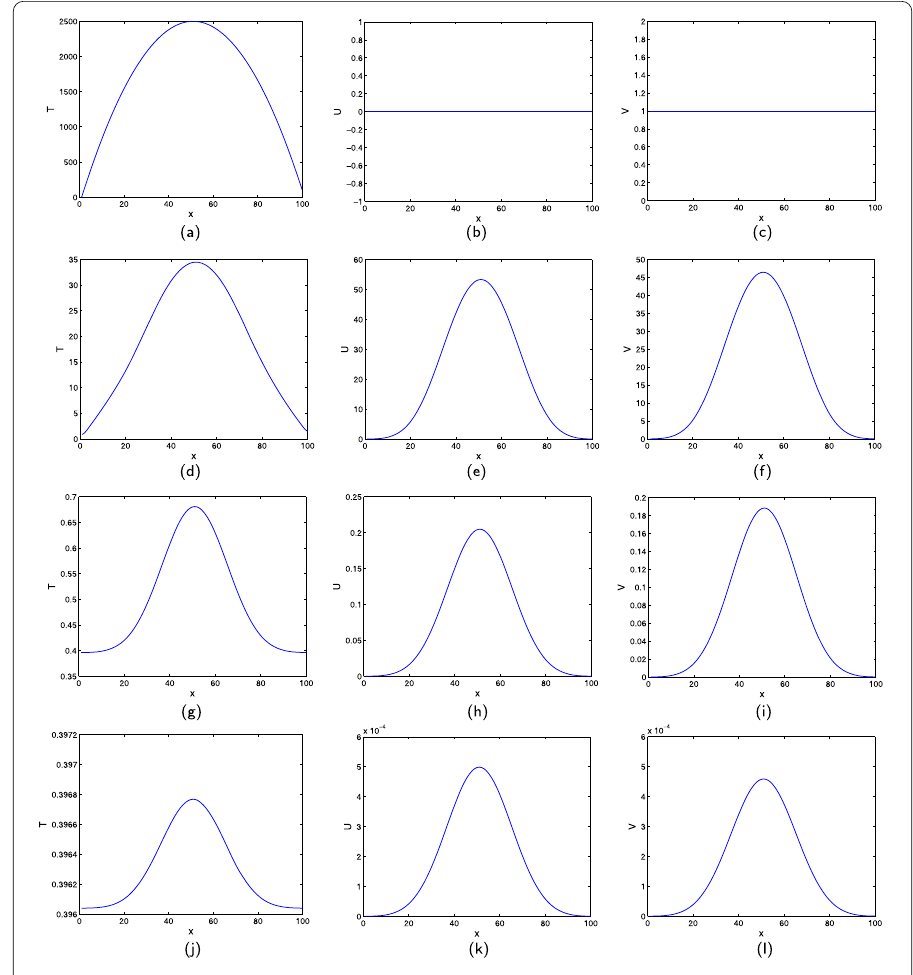
Figure 2 Snapshots of the approximate solutions T , U , and V of (1) for each row at the time t = 0, t = 1, t = 3, and t = 5. The parameters employed are λ = 0.1, β = 2, d = 5.05, κ = 0.03, δ = 0.016, γ = 3.0, c = 20.4, and N = 1000. We let φ T ( x ), φ U ( x ), and φ V ( x ) be as in Example 10. The approximations were calculated using our implementation of (76) in the Appendix, with τ = 0.00001 and h = 1